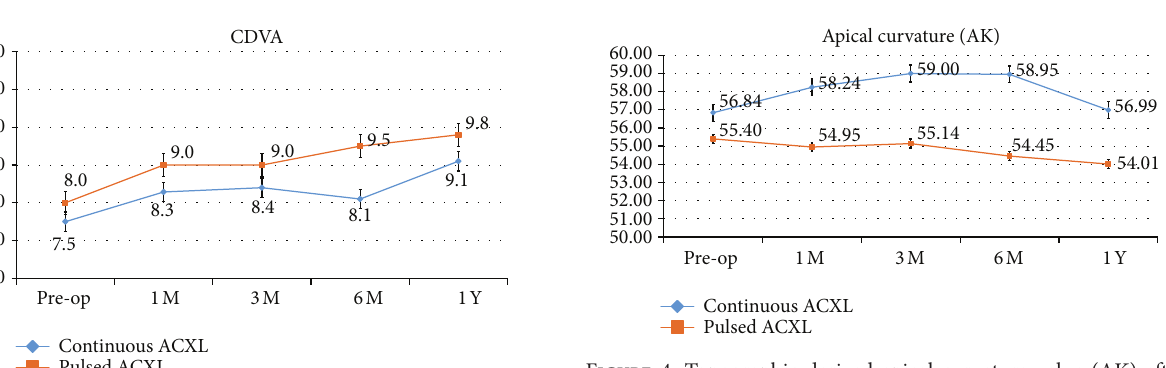
cells/mm 2 (range: 2082 to 3026 cells/mm 2 ) in the cl-ACXL group and 2672 cells/mm 2 (range: 2459–3016 cells/mm 2 )